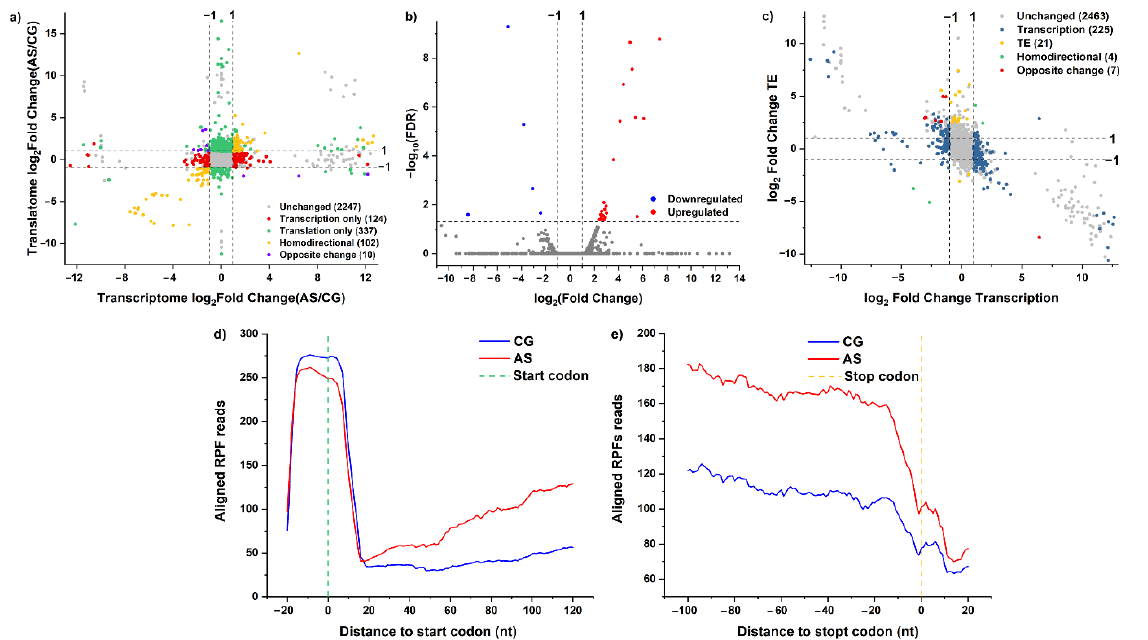
Figure 3. ( a ) The gene expression changes at the translational and transcriptional levels simultane- ously in L. rhamnosus ATCC 53103 under acid stress. ( b ) The volcano plot of the TE responses of DEGs under acid stress. ( c ) Simultaneous monitoring of the distribution of log 2 fold change TE and corresponding log 2 fold change mRNA abundance in L. rhamnosus ATCC 53103 under acid stress. The four dashed lines indicate log 2 fold change values of − 1 or +1. ( d ) The density of ribosomal footprints around the start codon under acid stress. ( e ) The density of ribosomal footprints around the stop codon under acid stress.